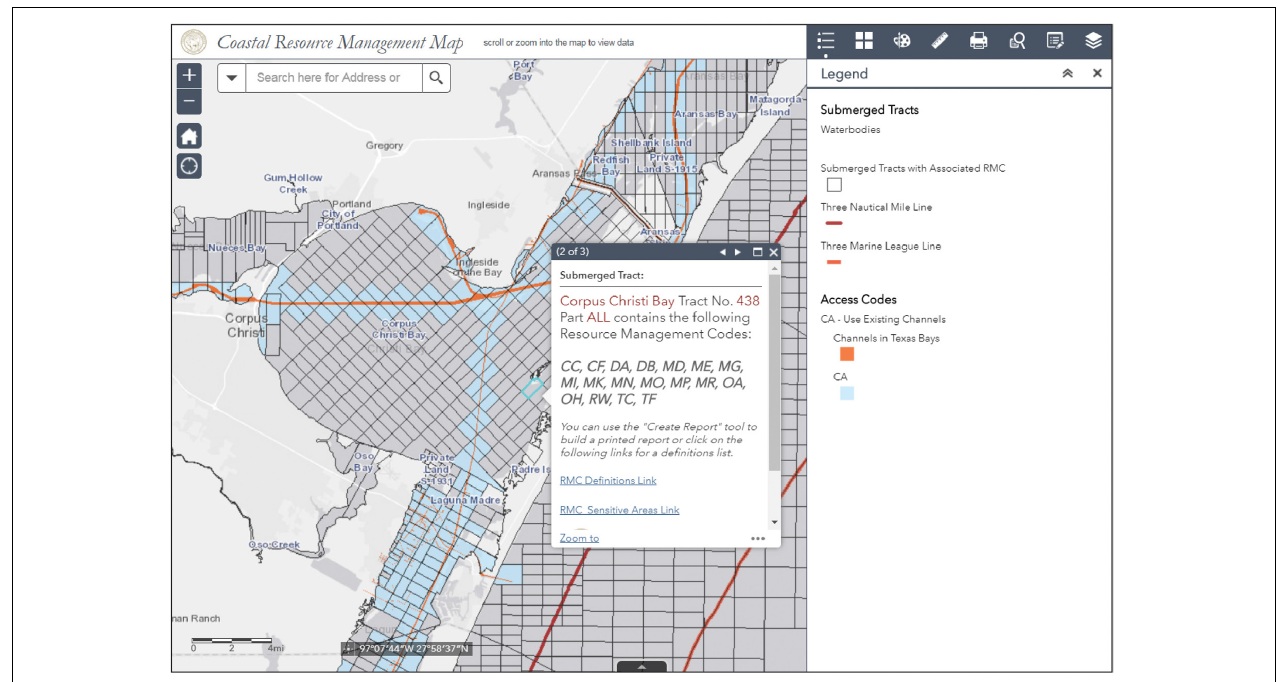
FIGURE 5 | Resource Management Code (RMC) web viewer featuring lease sale nominations and RMC pertaining to type of access limitations. Image courtesy of Texas General Land Office.